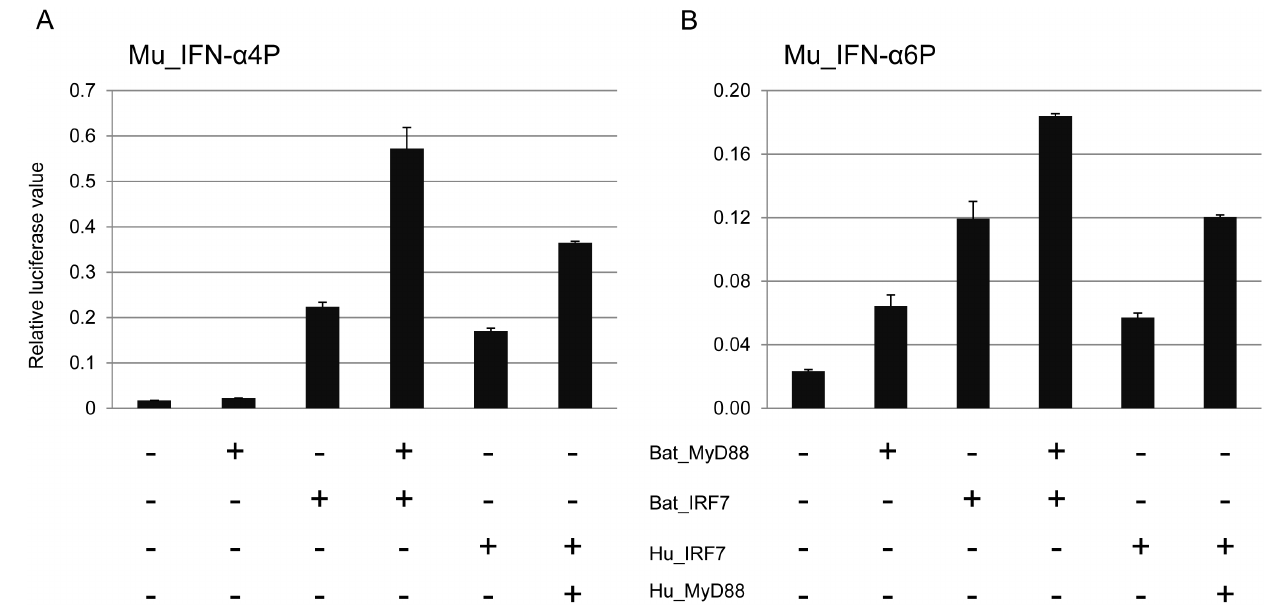
Figure 5. Bat IRF7 activation by bat MyD88. HEK293T cells were transiently co-transfected with bat MyD88 expression plasmid and mouse IFN- a 4 (A) or IFN- a 6 (B) promoter plasmid along with human IRF7, bat IRF7. After 30 h, cells were analysed for promoter activity by reporter gene luciferase assay. Data are mean values of two independent experiments and error bars represent standard errors.